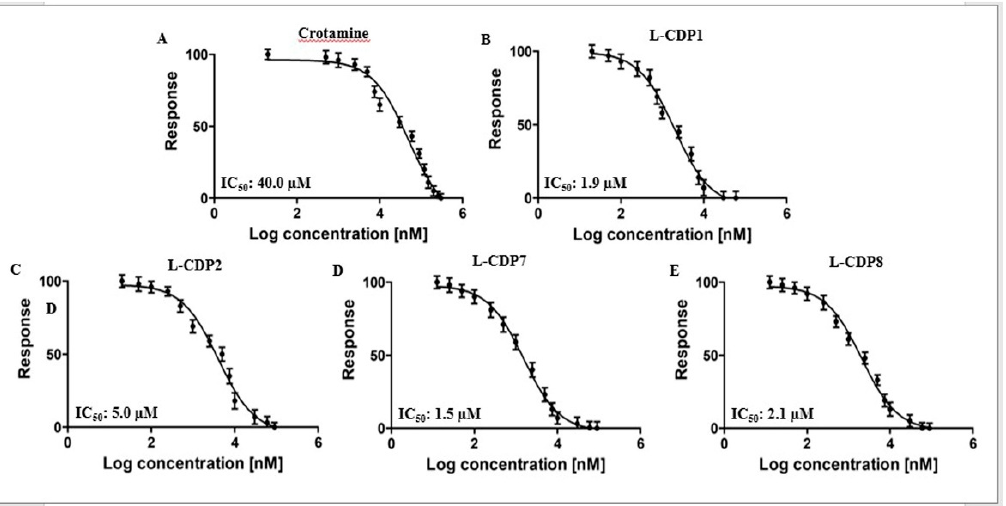
Figure 2. Crotamine, L-CDP1, L-CDP2, L-CDP7, and L-CDP8 inhibitory activity against SARS-CoV-2 3CL pro . Dose-response curves for IC 50 determination. The normalised response [%] of SARS-CoV-2 3CL pro is plotted against the log of the inhibitor concentration. ( A ): Dose-response curve of crotamine and SARS-CoV-2 3CL pro . ( B ): Dose-response curve of L-CDP1 and SARS-CoV-2 3CL pro . ( C ): Dose-response curve of L-CDP2 and SARS-CoV-2 3CL pro . ( D ): Dose-response curve of L-CDP7 and SARS-CoV-2 3CL pro . ( E ): Dose-response curve of L-CDP8 and SARS-CoV-2 3CL pro . Data shown are the mean ± SD from three independent measurements ( n = 3).